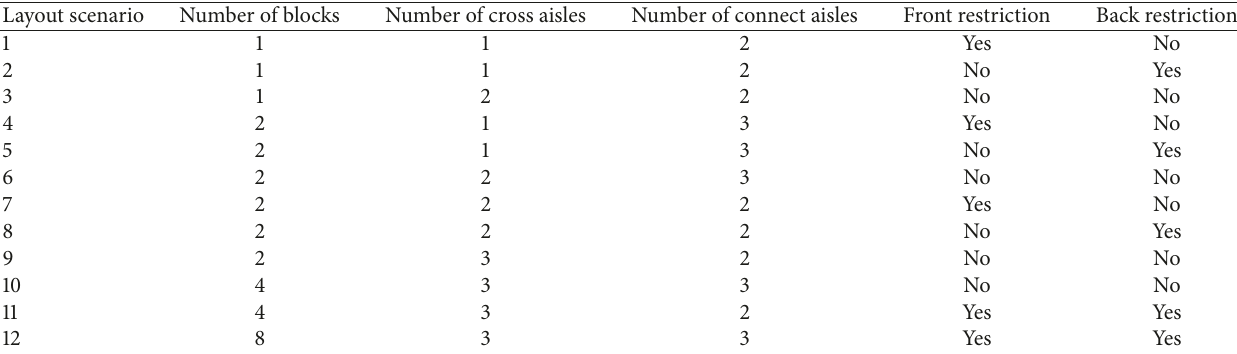
Figure 11: The percentage difference between AGNA and RNA in scenarios with two or three CNA s. Table 1: Detailed configurations of warehouse scenarios.